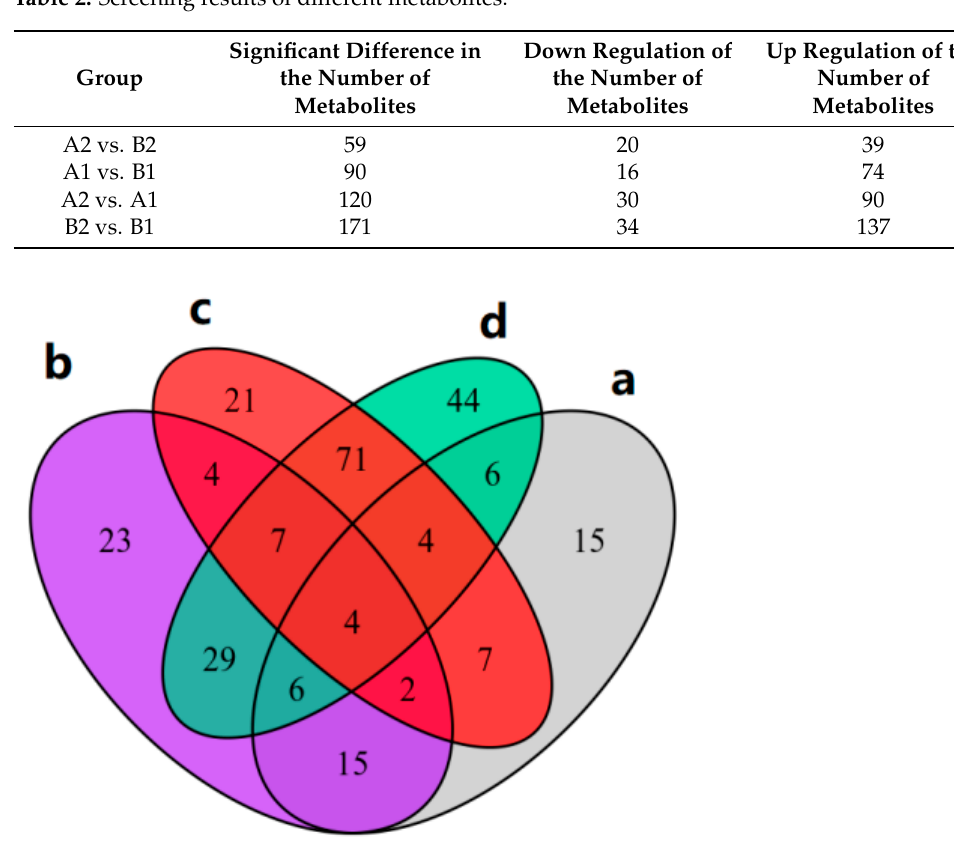
Figure 5. Venn diagram of different metabolites in the mix flower buds of each group. ( a ) Two mixed flower buds in pre-winter; ( b ) Two mixed flower buds in post-winter; ( c ) The CMF in pre- and post-winter; ( d ) The IMF in pre ‐ and post ‐ winter.